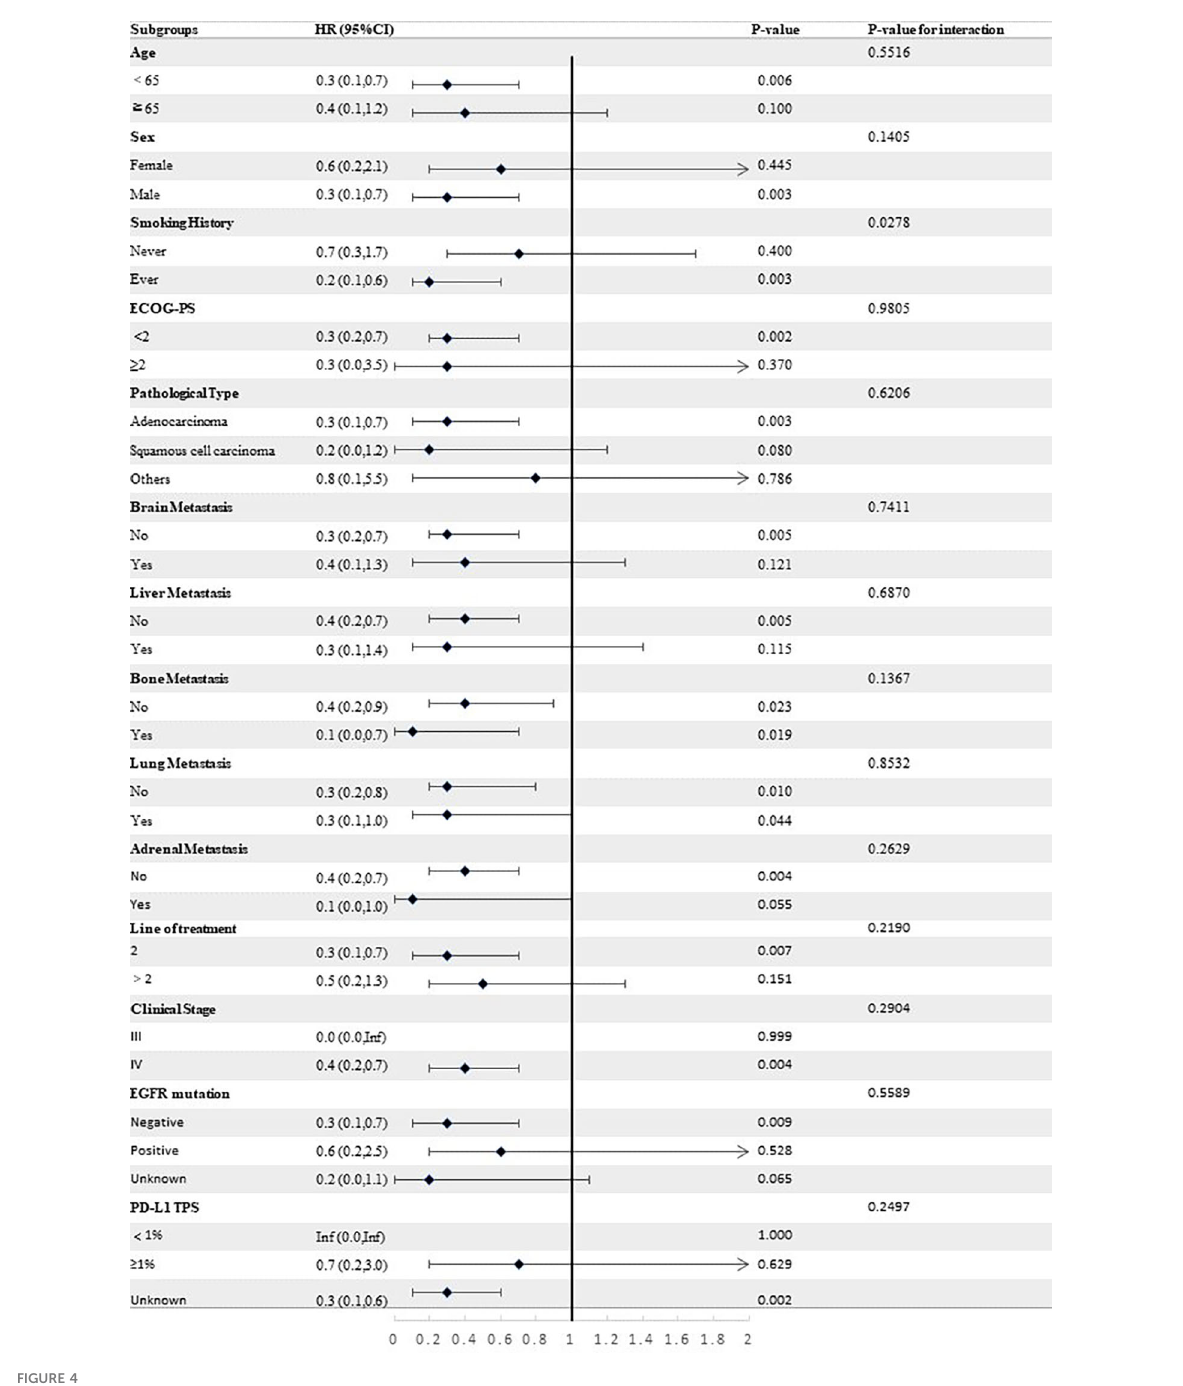
FIGURE 4 Forest plot of risk of disease progression for patients in PA group compared to PC group in different